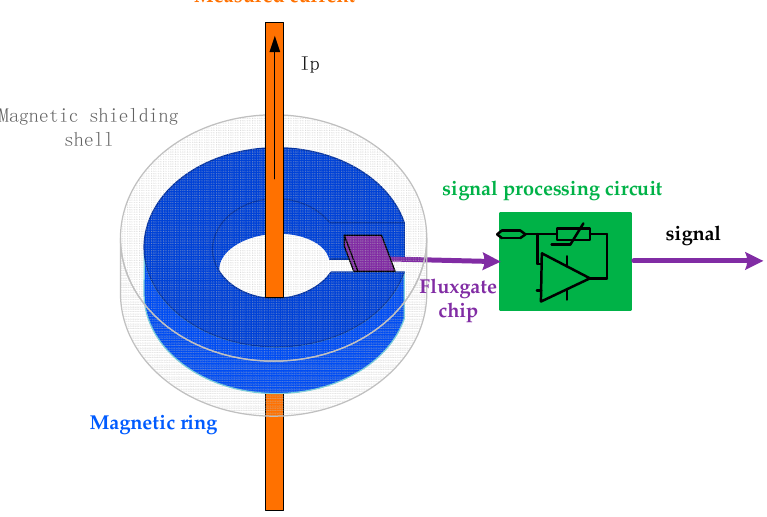
Figure 1. Fluxgate current sensor structure.